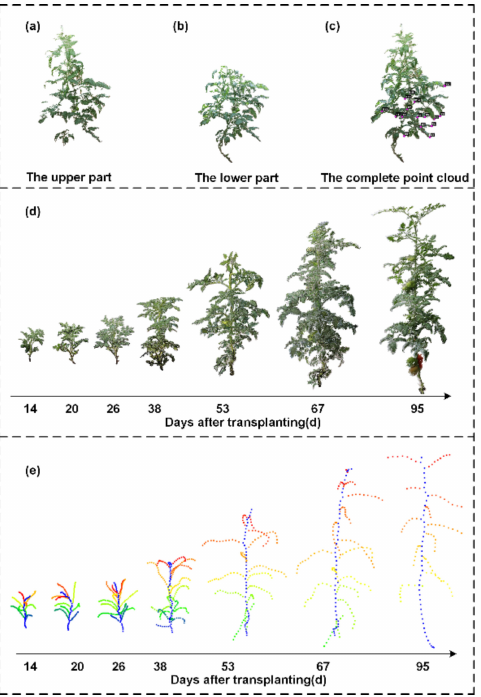
Figure 3. Visualization of reconstruction and stalk skeletonization. Point clouds for ( a ) the upper part and ( b ) lower part of one tomato plant and ( c ) a complete tomato plant model after alignment. ( d ) All growth stages of one tomato plant at 7 time points. ( e ) The stalk skeletonization results of one tomato plant at 7 time